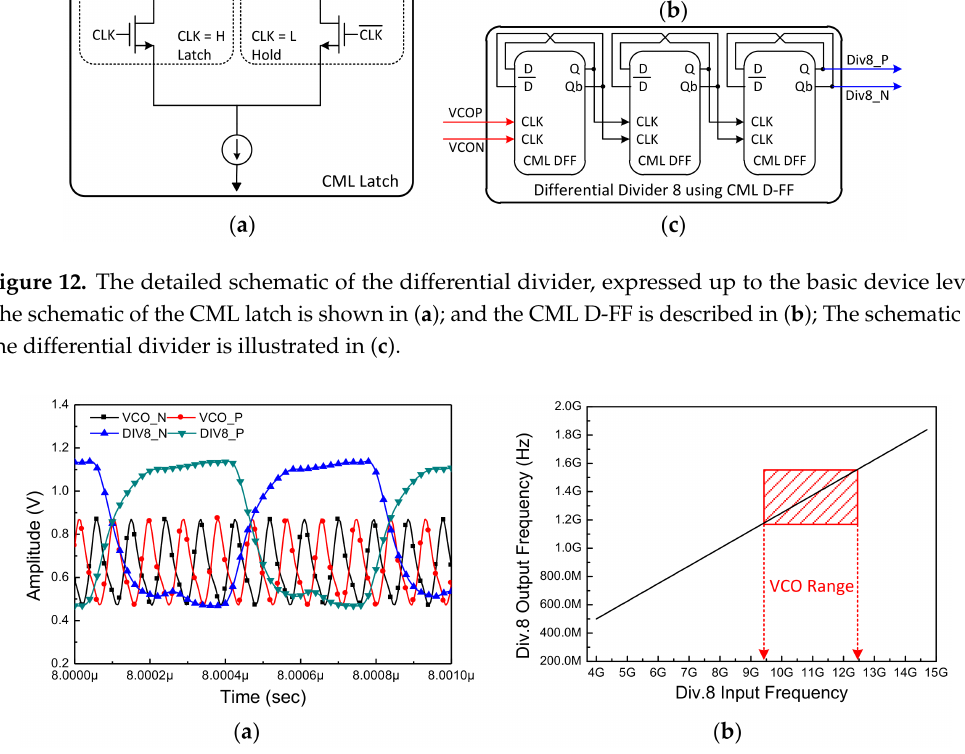
Figure 13. The simulation result of the differential divider ( a ) in time domain and ( b ) the range of input frequencies that can be divided by the differential